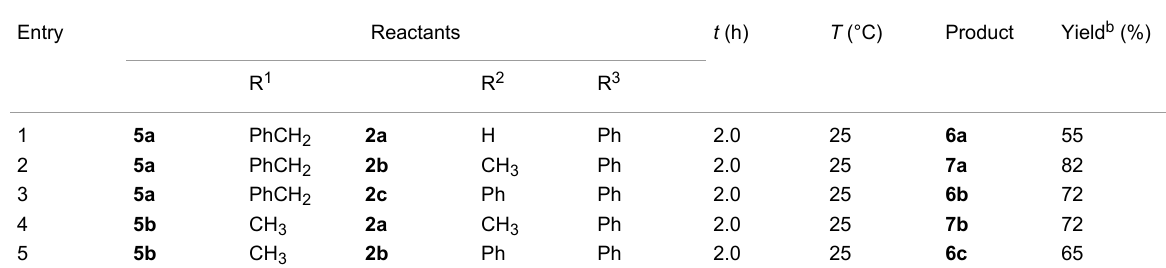
Table 4: The reactions of 5-hydroxypyrrol-2-ones 5 with olefins 2 in the presence of BF 3 ·OEt 2 .